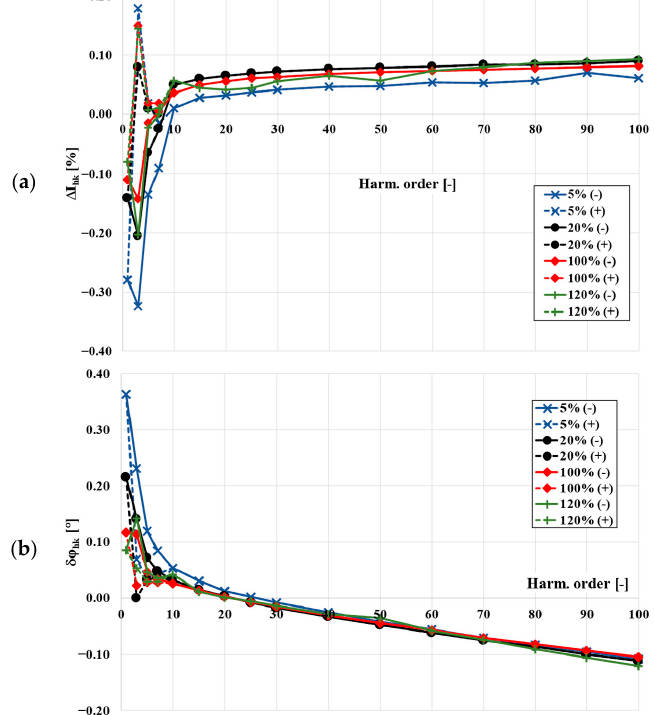
Figure 5. Influence of the rated resistive load of the secondary winding of the 100 A/5 A CT on its accuracy: ( a ) current error, ( b ) phase displacement.